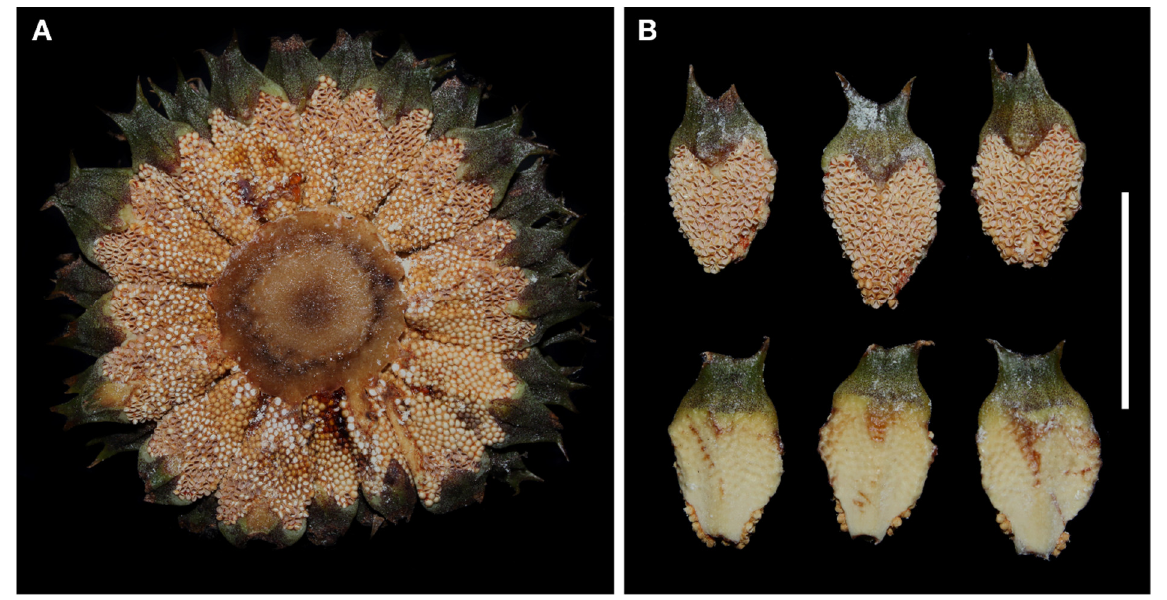
Figure 8. Microsporophylls of Ceratozamia schiblii . ( A ) Transversal sectioned microstrobilus (pollen cone) with exposed microsporophylls. ( B ) Microsporophylls abaxial side ( top ) and adaxial side ( bottom ). Scale = 2 cm. Photos by José García González.